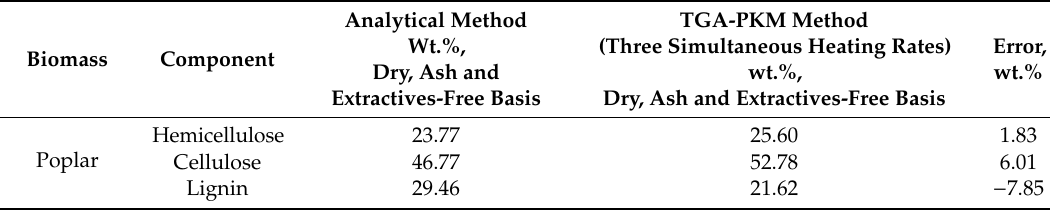
Table 12. Comparison between TGA-PKM results using three simultaneous heating rates and the analytical